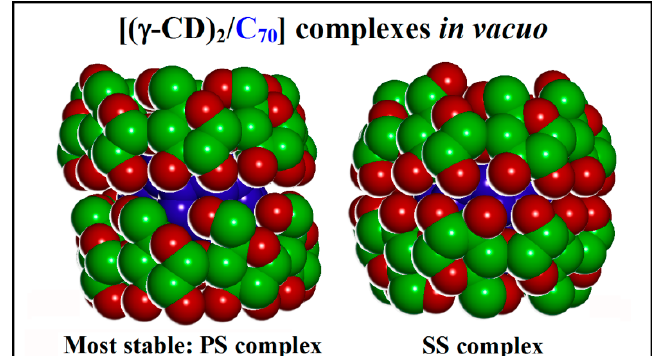
Figure 4. At left, the side view of the most stable inclusion complex in a 2:1 stoichiometry [( γ -CD) 2 / C 70 ] formed in vacuo by the stable initial 1:1 [( γ -CD)/C 70 ] complex facing it with another γ -CD through its secondary rim, so that eventually the two γ -CD's interact through their primary and secondary rim, respectively (PS complex). At right, the side view of the less stable inclusion complex in a 2:1 stoichiometry [( γ -CD) 2 /C 70 ] formed in vacuo facing the two secondary rim of the cyclodextrins (SS complex). The color code is the same of Figure 1. Here, the H atoms are omitted for clarity.